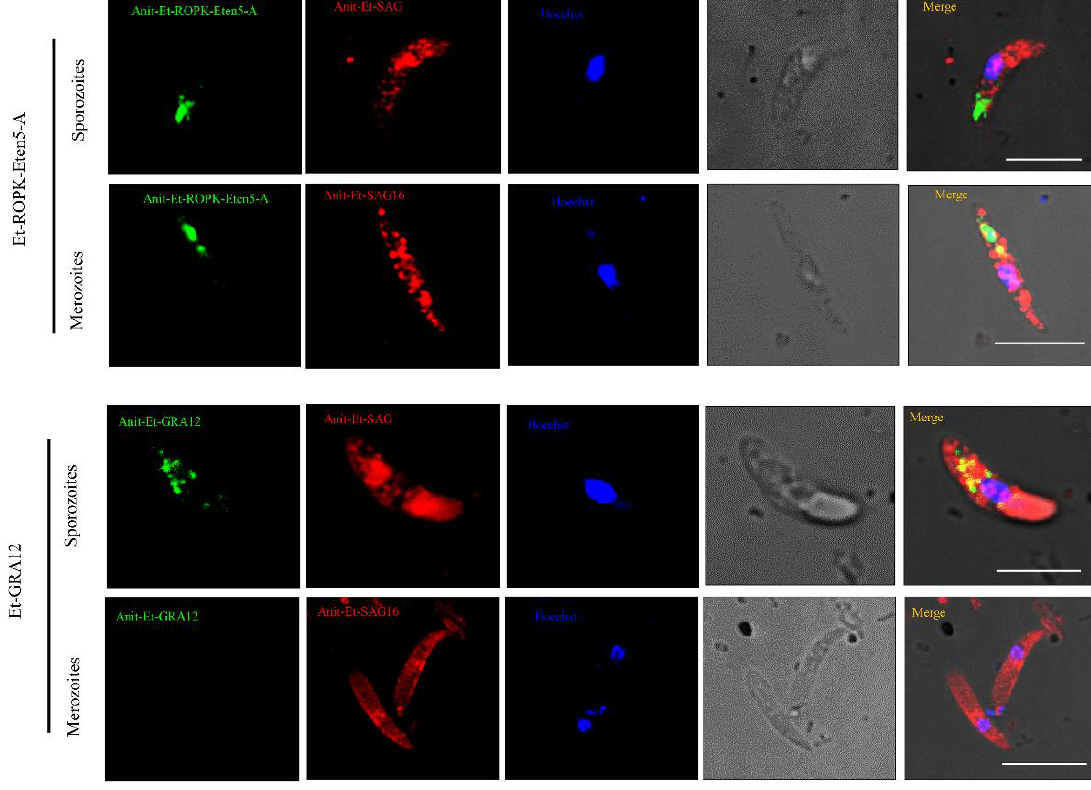
Figure 6. Immunofluorescence localization of Et-ROPK-Eten5-A and Et-GRA12 in different stages of E. tenella . Immunofluorescence localization of Et-ROPK-Eten5-A and Et-GRA12 in sporozoites and merozoites using mouse anti-rEt-ROPK-Eten5-A and mouse anti-r Et-GRA12 serum. Scale bars: 10 µ m. Et-SAG and Et-SAG16 (red) served as parasite surface markers. The morphology of parasites under a light microscopes is shown in the penultimate column.